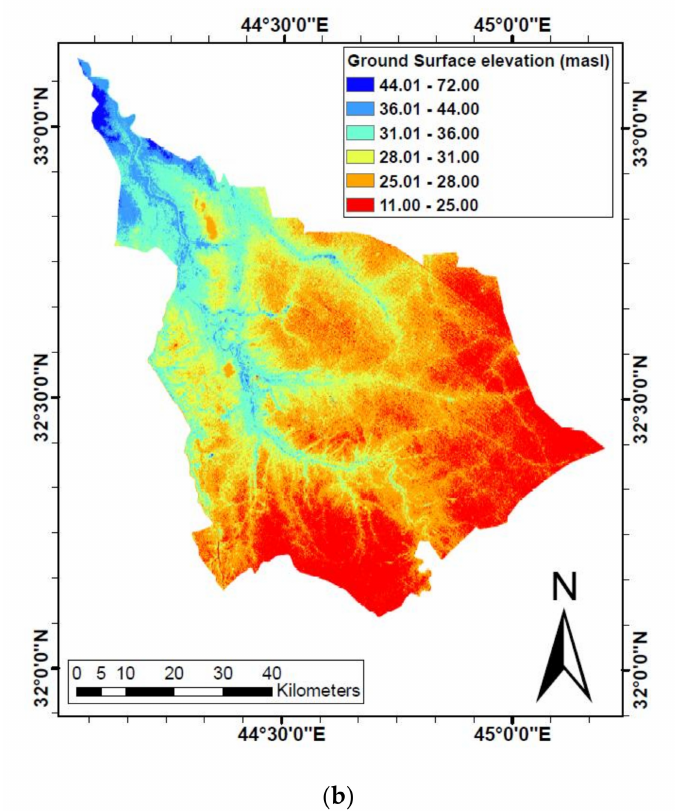
Figure 2. Babylon study area, ( a ) geomorphology of Babylon study area, ( b ) ground surface elevation (m.a.s.l.) map; a modified after